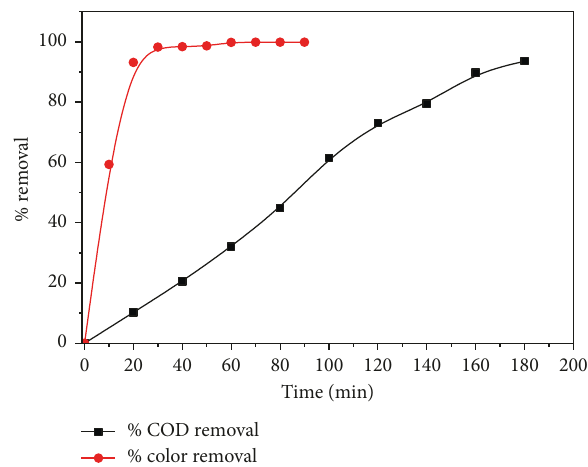
Figure 9: COD and color removal during the electrochemical treatment of Rh-B under optimal conditions: [NaCl], 0.07mol · L − 1 ; [Rh-B], 200mg · L − 1 ; current density, 3.9mA · cm − 2 ; T , 25 ° C; flow rate, 30L · h − 1 .